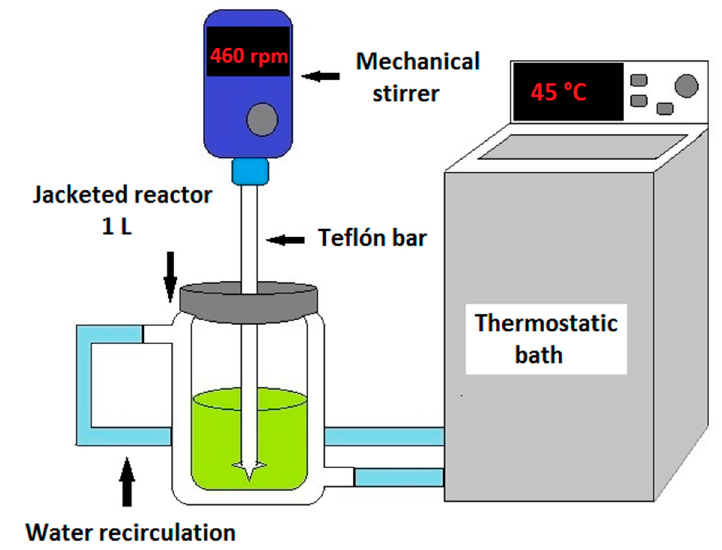
Figure 1. Schematic picture of experimental tests.